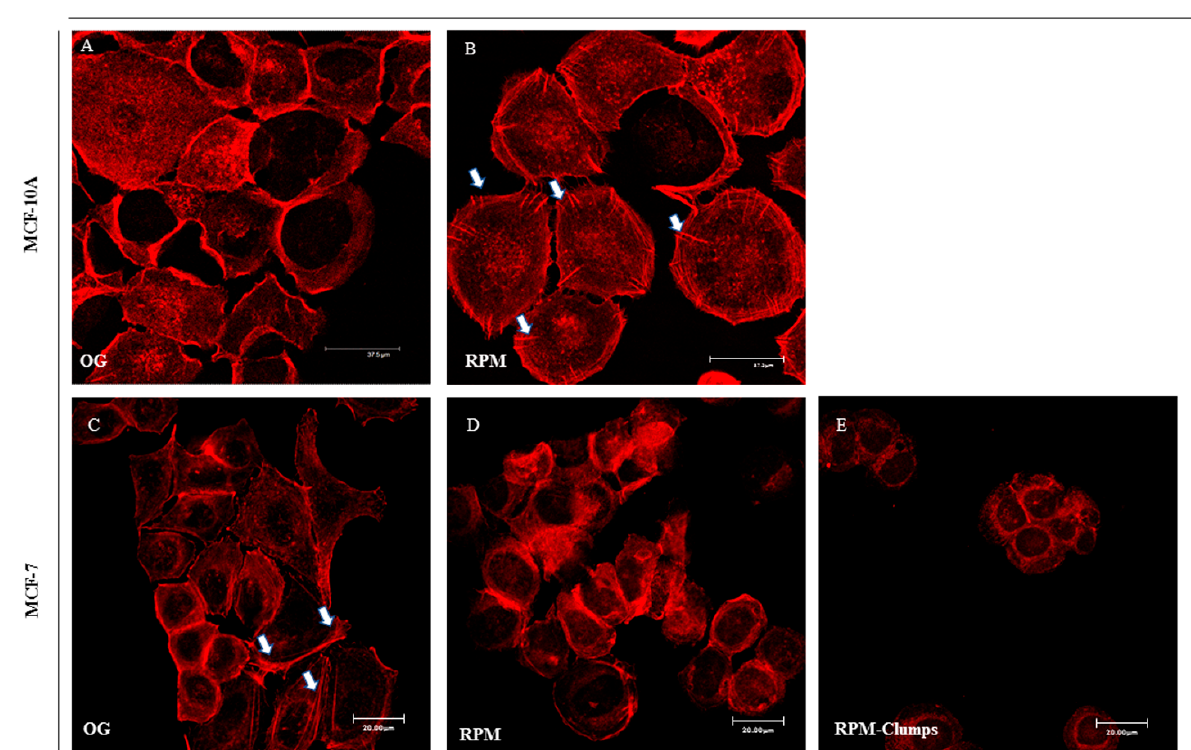
Figure 4. Confocal images of F-actin distribution pattern in MCF-10A ( A , B ) and MCF-7 ( C – E ) cultured in normal gravity (OG) and microgravity (RPM) conditions for 24 h. MCF-10A cells cultured in RPM conditions ( B ) show actin bundles orthogonal to the periphery of plasma membrane (arrows; scale bar 37.50 µm), while F-actin fibers appear well-organized in MCF-7 cultured in the on-ground condition ( C , arrows, scale bar 20 µm). In RPM-AD cells, stress fibers are slightly reduced, while F-actin was mostly localized at the cell border ( D ). On the contrary, in RPM-CLUMPS cells the actin filaments are fragmented and significantly reduced ( E ), mostly positioned at the perinuclear level of floating cells €.